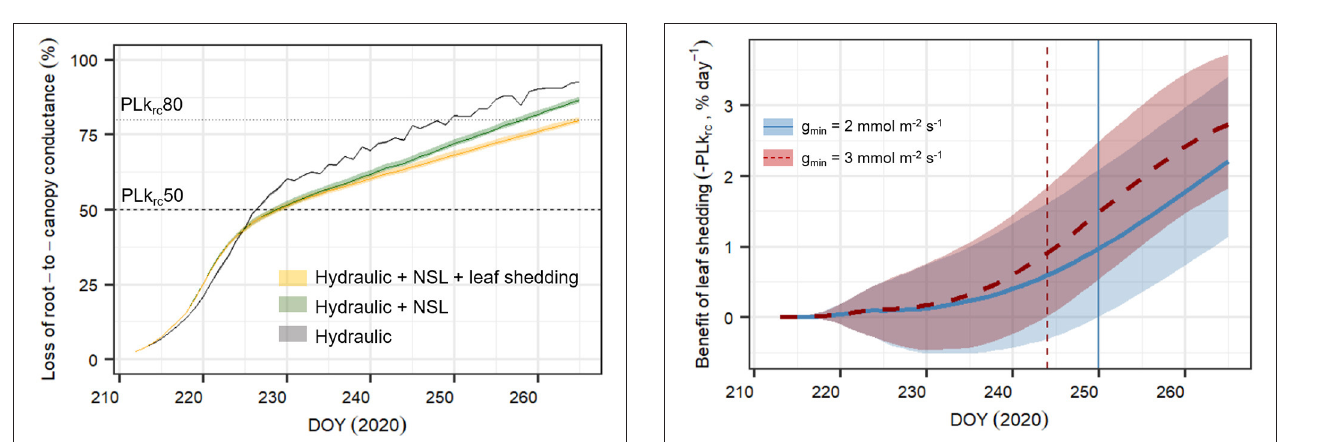
FIGURE 7 | Simulated percent loss in root-to-canopy conductance during the experiment ( PLk rc , in %) with three different SOX + model formulations. Only hydraulic constraints on stomatal conductance (Hydraulic, in gray); hydraulic constrains on stomatal conductance and non-stomatal limitations of photosynthesis accounting for equal leaf area during the whole experiment (Hydraulic + NSL, in green); and hydraulic constraints on stomatal conductance, non-stomatal limitations of photosynthesis, and observed leaf shedding (Hydraulic + NSL + leaf shedding, in orange). Posterior parameter distributions are different for (Hydraulic) and (Hydraulic + NSL, Hydraulic + NSL + leaf shedding), see Table 2 . For each model formulation, the figure shows the daily pre-dawn median ± 95% CI PLk rc , obtained from running the simulation by sampling 500 times the posterior parameter distribution. Horizontal lines indicate when k rc = 0.5 * k rc , max ( PLk rc 50 , dashed line), and when k rc = 0.2 * k rc , max ( PLk rc 80 , dotted line), a threshold that has been found to be critical for pine survival probability ( Hammond et al., 2019).